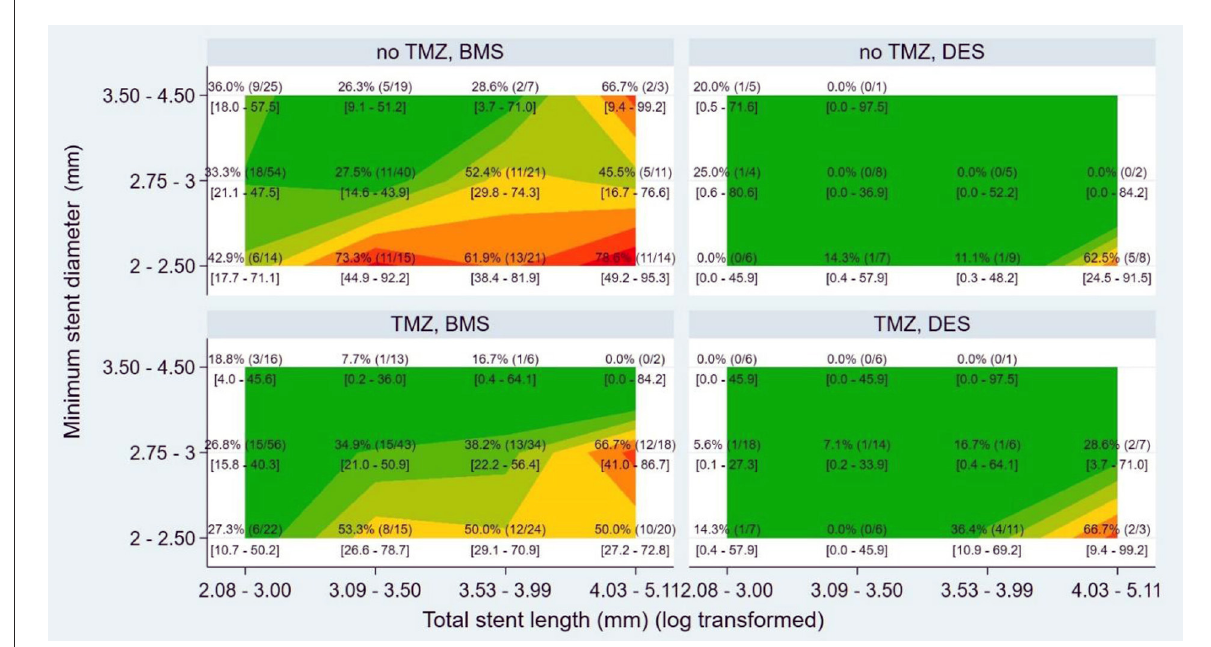
FIGURE3 Heat map presenting the effect of trimetazidine (TMZ) in relation to stent-dependent parameters. DES, drug eluting stent; BMS, bare metal